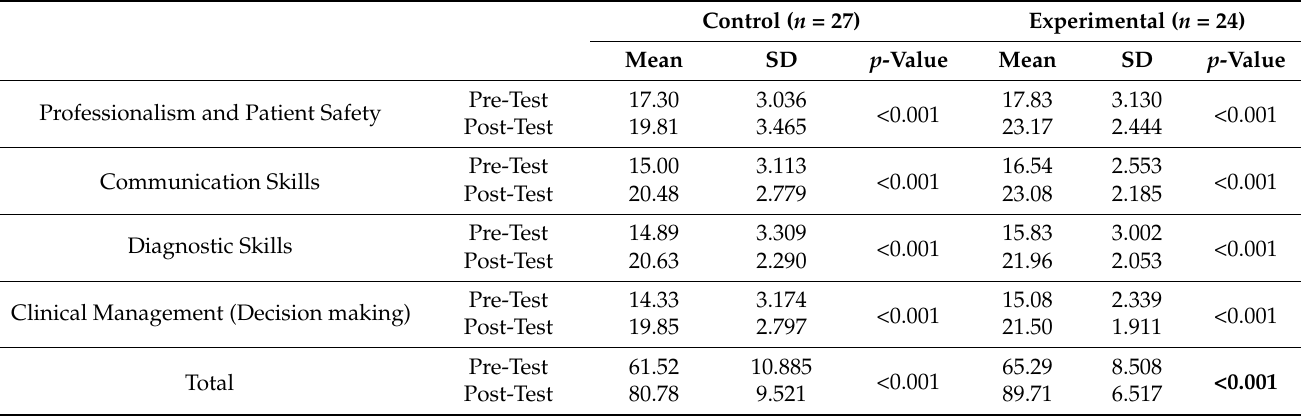
Table 1. Comparisons between OSCE pre-test and OSCE post-test scores of each group.